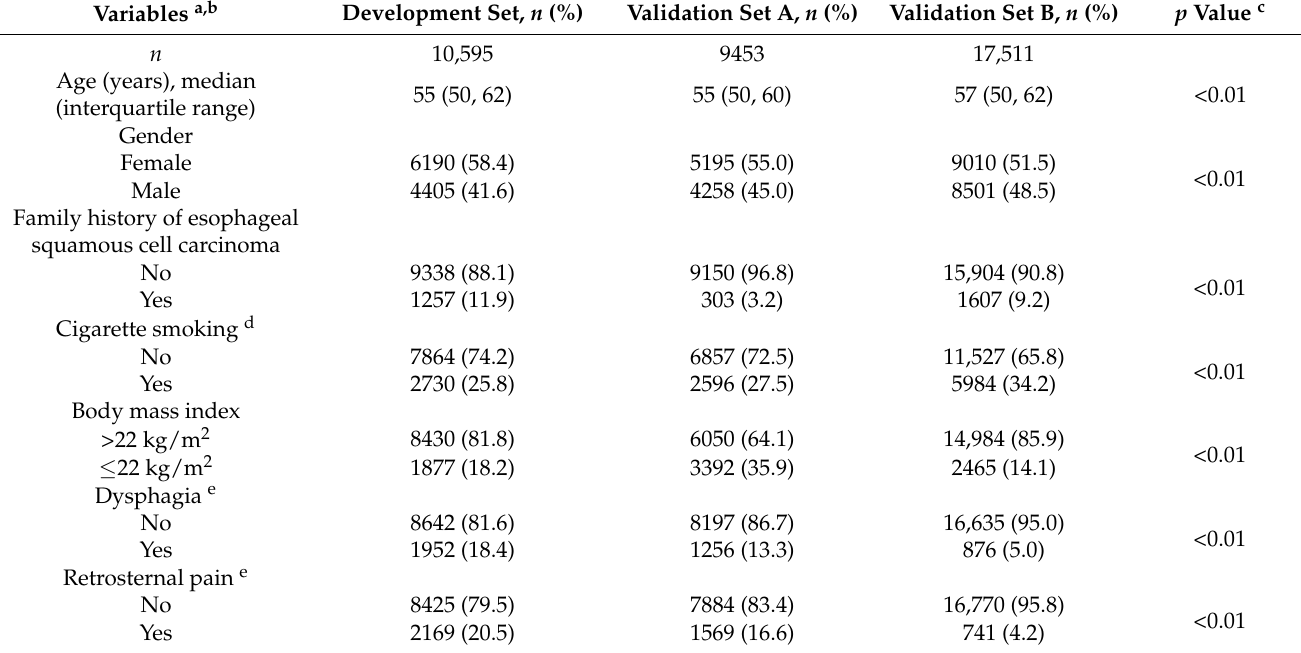
Table 1. Selected characteristics of individuals in the development set, validation set A, and validation set